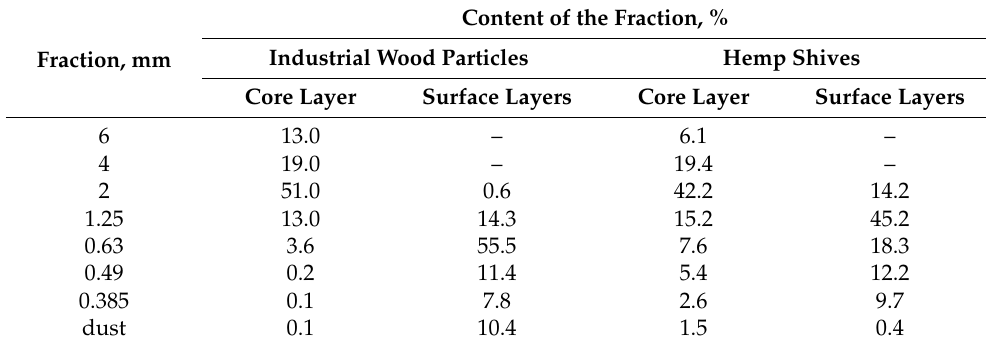
Table 1. The fractional compositions of the particles used for the core layer and surface layers.